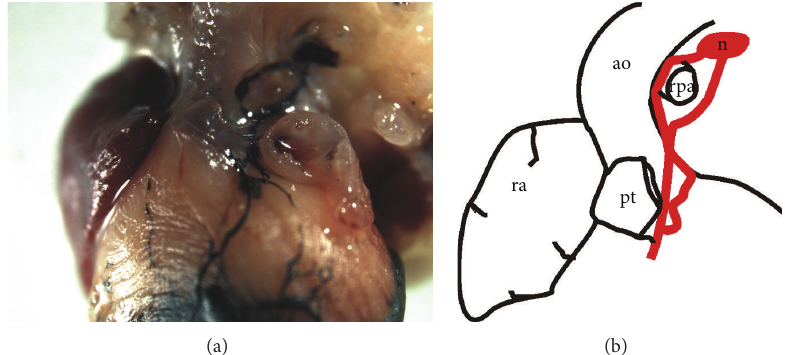
Figure 1: (a) A photography of an India-ink-injected adult mouse heart demonstrating the structure and the route of the major lymphatic collector; (b) a scheme showing the extracardiac route of this collector terminating in a regional lymph node (in red); ra—right auricle; pt—pulmonary trunk; rpa—right pulmonary artery;